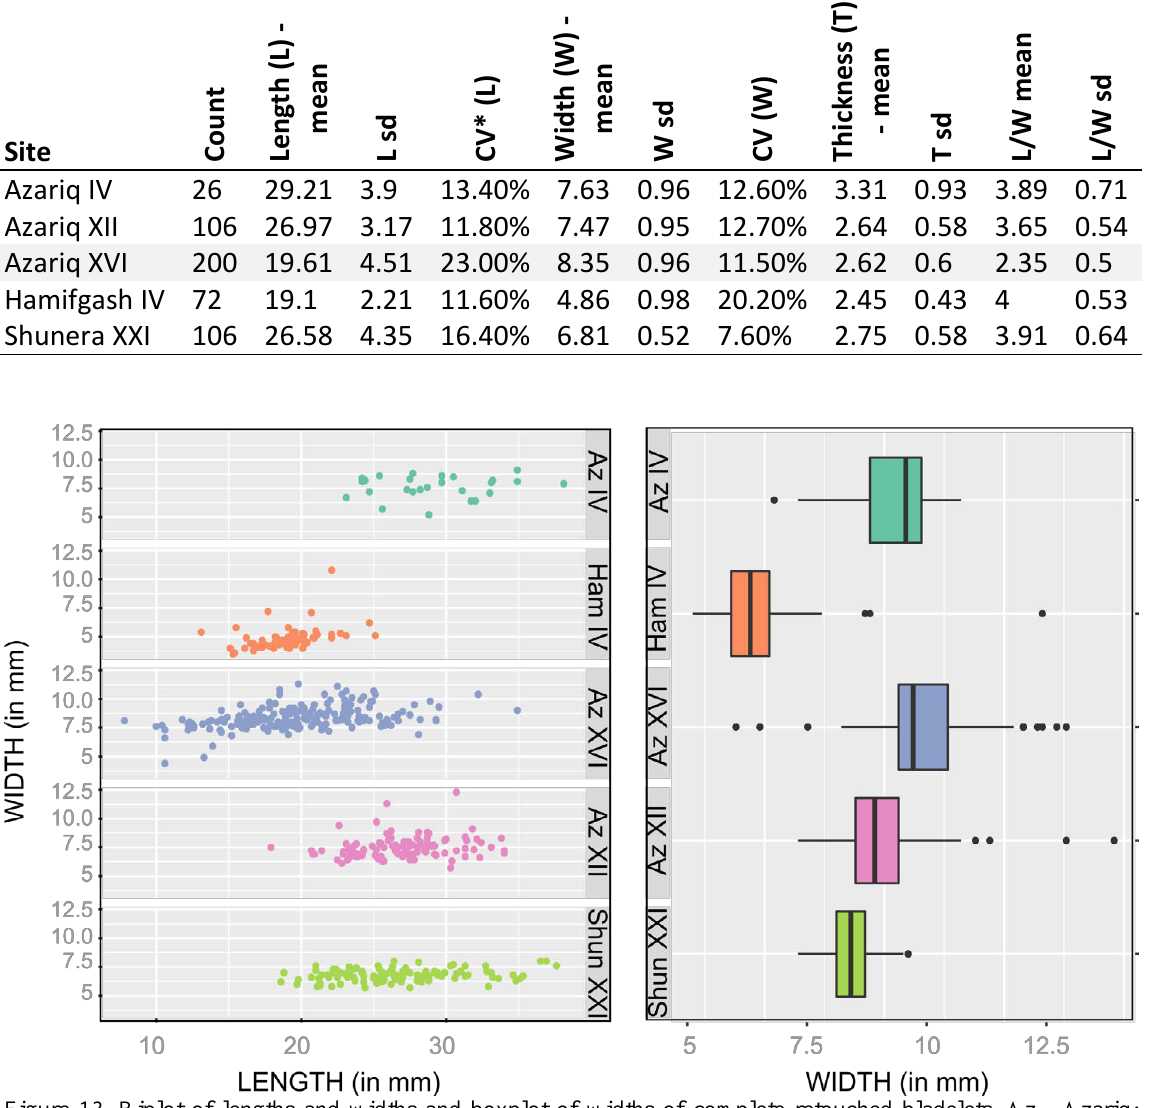
Table 13. Main statistics for complete microliths. Abbreviations: CV = coefficient of variation = sd/mean*100